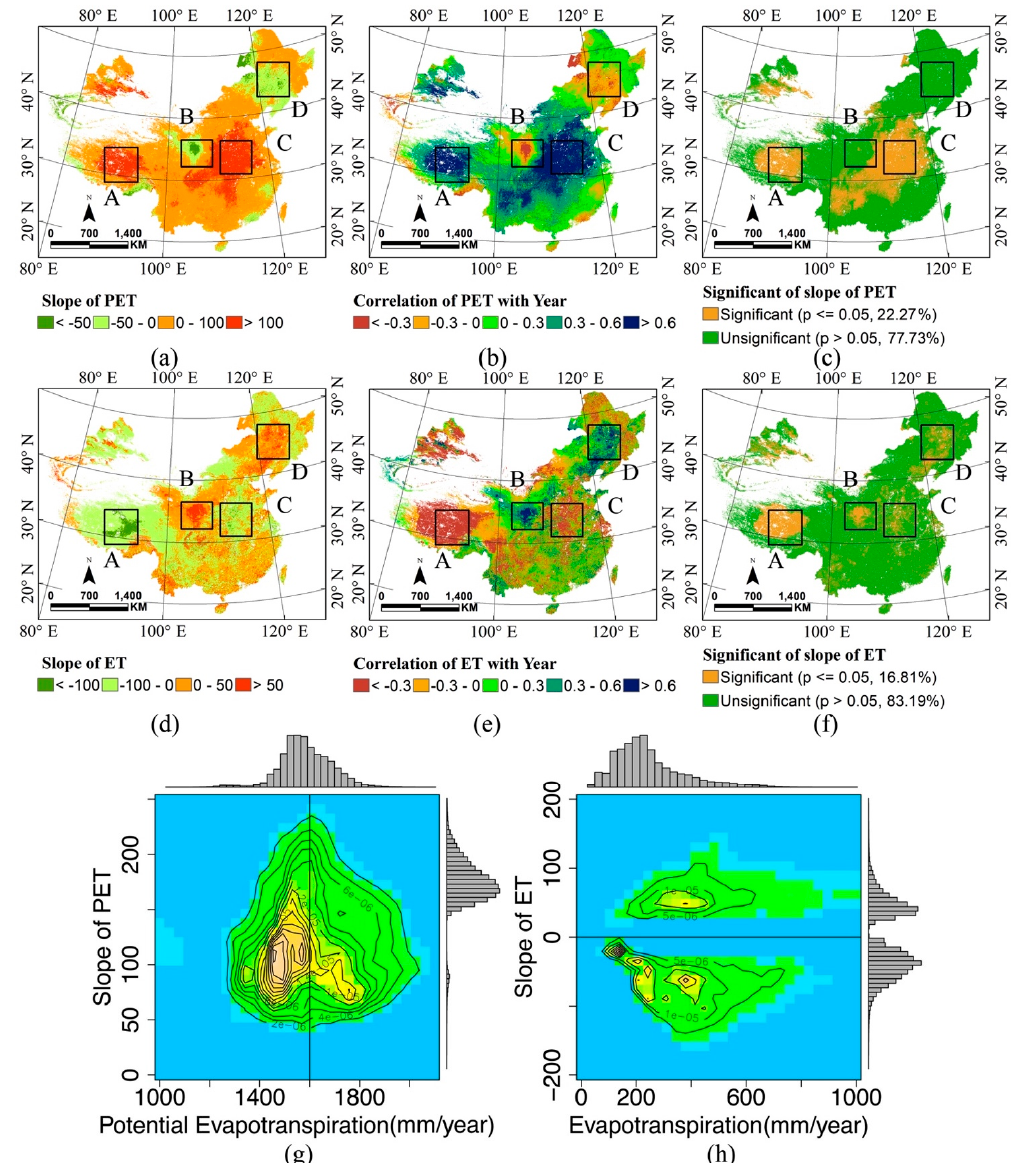
Figure 6. Geographical distribution of the linear regression characteristics for potential evapotranspiration (PET) and evapotranspiration (ET) over a 14-year period (2000 to 2013): ( a ) trends of PET; ( b ) correlation of PET; ( c ) significant of PET; ( d ) trends of ET; ( e ) correlation of ET; and ( f ) significant of ET. Four sub-regions were selected: A, Qinghai-Tibet Plateau; B, Loess Plateau; C, North China Plain; D, Northeast Plain. Temporal change (tendencies) is presented in terms of frequency distributions in a (x, slope (x)) format for a significant change in slope ( p -value ≤ 0.05 & |R| > 0.5) for regions with ( g ) PET and ( h ) ET.